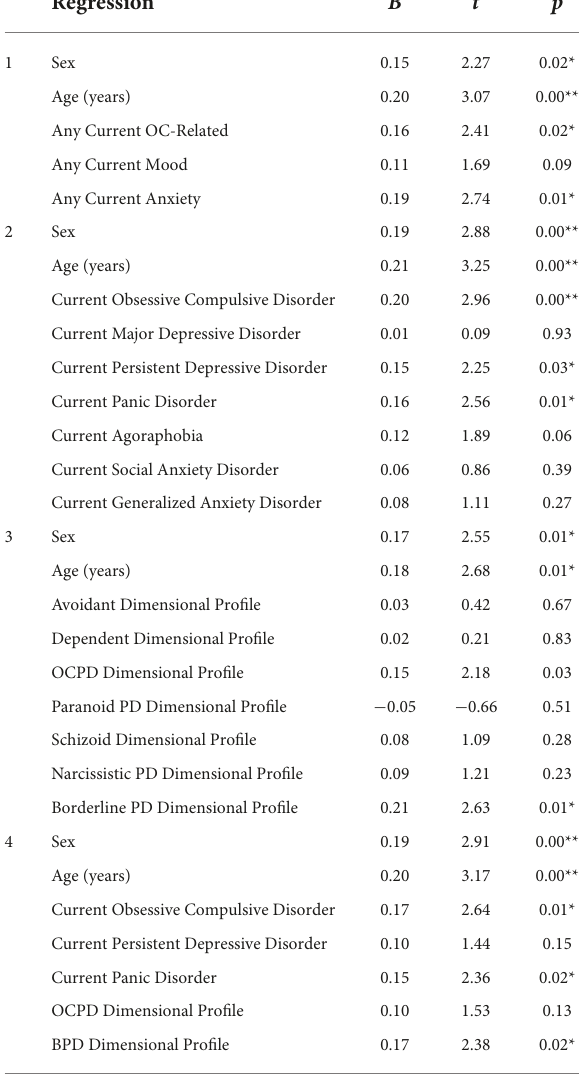
TABLE 6 Coefficient statistics from the full models of the four regression